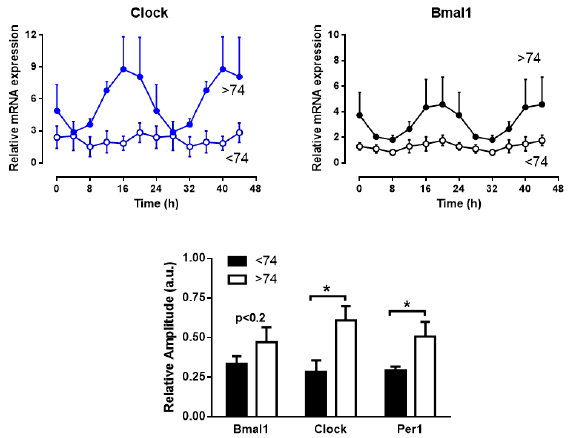
Figure 5. Clock genes rhythms in muscle colon are enhanced in subjects above 74 years old. The two top graphs show the averaged rhythms of Clock and Bmal1 expression in colon muscle explants from donors aged below ( n = 6) and above ( n = 3) 74 years. The lower histogram depicts mean ± SEM of the relative amplitude of the rhythms for the two groups of age. * p < 0.05.